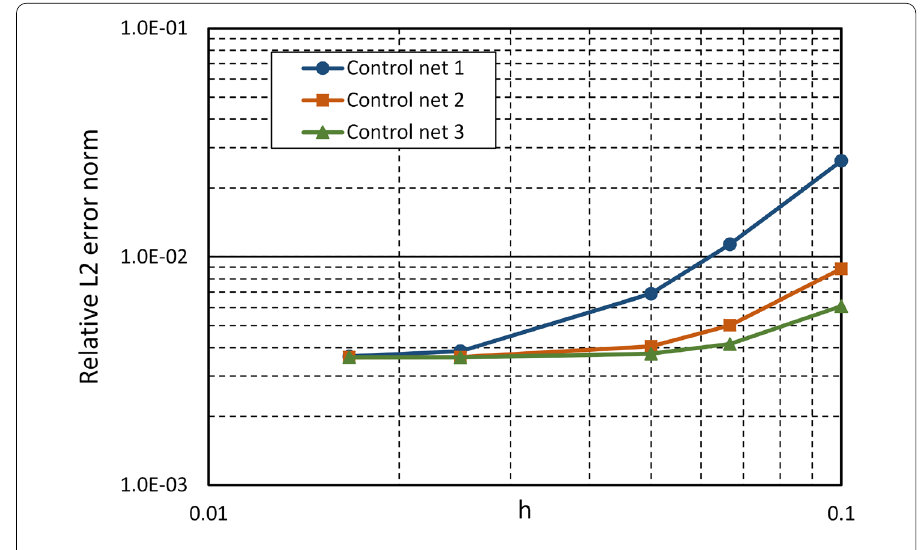
Fig. 19 Convergence analysis